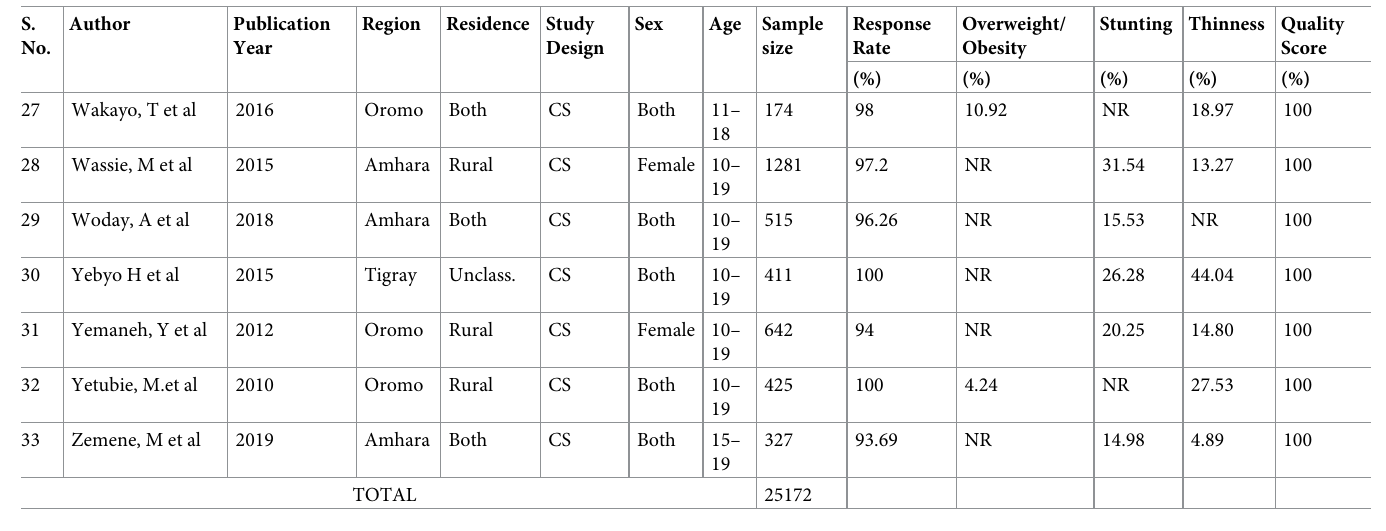
estimate the pooled prevalence of adolescent stunting [1,4,41,42,44,45,47–50,52,54,56–63,66– 69,71]. The heterogeneity among the 25 studies used to estimate the pooled prevalence of ado- lescent stunting was high (I 2 = 97.0%, P < 0.001). Using the random-effects model, the overall pooled prevalence of adolescent stunting was 20.1% (95% CI: 15.61, 24.51) (Fig 3). Twenty-five studies were included to estimate the pooled prevalence of thinness [1,4,42,44– 50,52–54,56,58–61,63,65,66,68–71]. Heterogeneity among the studies used to estimate the pooled prevalence of adolescent thinness was high (I 2 = 99.7%, P < 0.001). The pooled preva- lence of adolescent thinness was 21.7% (95% CI: 9.56, 33.81) using random-effects model (Fig 4). Subgroup analysis for prevalence of adolescent double burden of malnutrition. Since there was high heterogeneity on the pooled effect of studies conducted on stunting and thin- ness, subgroup analysis were performed to identify the possible source of heterogeneity. The pooled prevalence estimated for adolescent stunting was high in Amhara Region (25.2%, 95% CI: 13.24, 37.11) and Tigray Region (25.4%, 95% CI: 18.36, 32.40), and the least was in Somalia (11.2% (95%CI: 7.24, 15.07). Heterogeneity was high except in Somalia Region (88.8–99.1%). Subgroup analysis by gender showed that comparable pooled estimate of stunting were (19.9%, 95%CI: 14.81–25.66) and (20.2% 95% CI: 12.47–27.96) among males and females, respectively. Heterogeneity was high (92.9%) among both sexes. High heterogeneity was also observed in other subgroups; residence, age, study design and sample size (Table 4). The pooled estimate of adolescent thinness was high in Tigray Region (32.4, 95%CI: 24.63, 40.16) and least in Addis Ababa and Afar (7.7, 95%CI: 2.88, 12.61). Heterogeneity was high except in Addis Ababa and Afar Region 84.6–99.8%. Another subgroup analysis showed that adolescent thinness was high in sample size of � 384 (23.3%, 95%CI: 8.35, 38.19). Subgroup analysis by gender showed that pooled estimate of thinness was high among males (27.9%